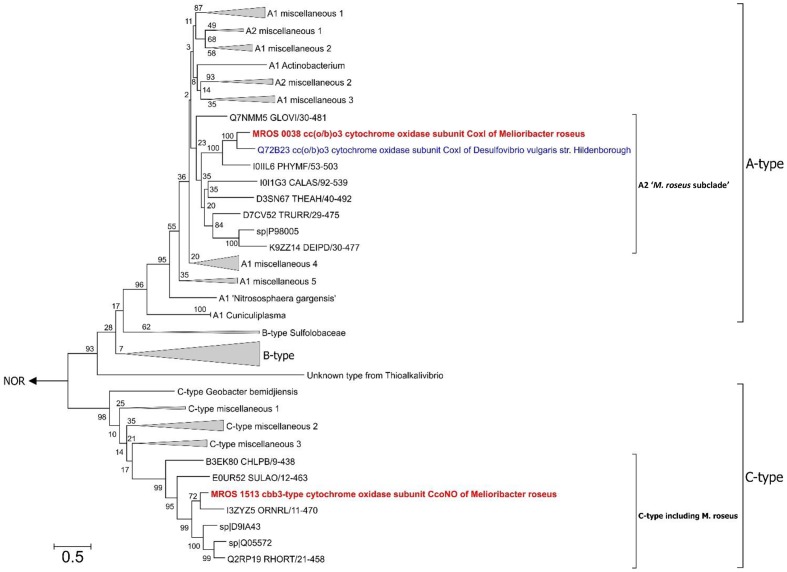
Maximum Likelihood phylogenetic tree of PF00115 domain (COX1 family, heme-copper oxygen reductases) sequences. Refer to the text for the description of A2 ‘M. roseus subclade’. After 50% sequence identity filtering of PF00115 sequences from the “seed” data-set (http://pfam.xfam.org/family/pf00115#tabview=tab3) a total of 112 sequences were used for the analysis. The tree with the highest log likelihood is shown. The bootstrap values (1000 replicates) are shown next to the branches. All positions with less than 95% site coverage were eliminated. There were a total of 367 positions in the final dataset. The tree was constructed in MEGA6 (Tamura et al., 2013). The “unknown group” was first introduced by Muntyan et al. (2015). Nitric oxide reductases (NOR) were used as an outgroup. CoxI protein of the cc(o/b)o3 cytochrome oxidase (A2-subtype) and CcoNO protein of the cbb3 oxygen reductase (C-type) of M. roseus are in bold red, and CoxI protein of oxygen detoxificating cc(o/b)o3 cytochrome oxidase of D. vulgaris str. Hildenborough is in bold blue. Bar is 0.5 substitutions per site.